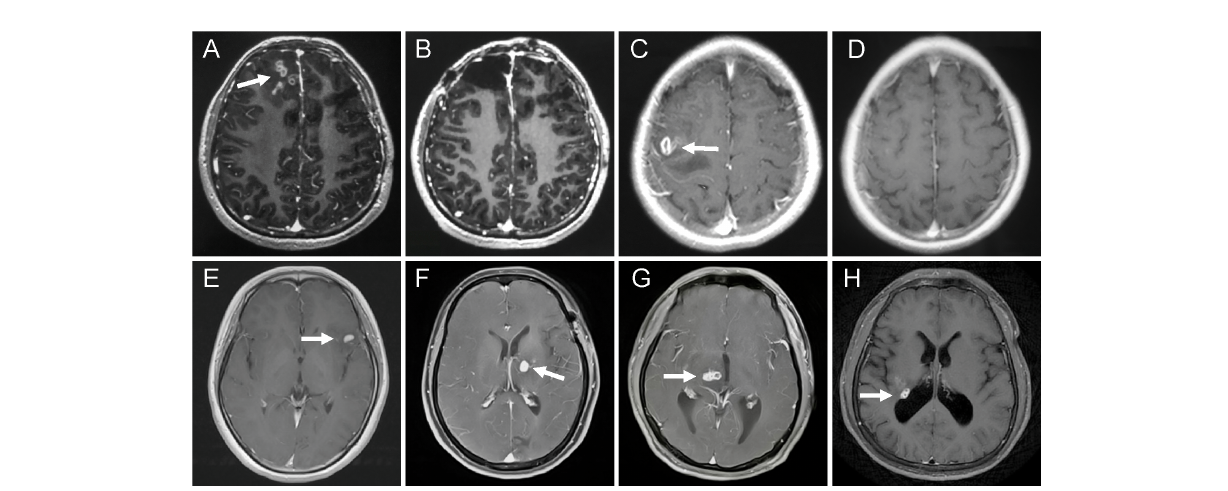
FIGURE 1 MRI changes of the patients with different treatment options and outcomes. (A – D) patients with good outcomes. (A) axial T1-weighted images revealed aggregated bead-shaped enhancement in the subcortical area of the right frontal lobe. (B) the active lesions were removed by surgery. (C) axial enhanced MRI showed nodular enhanced lesions in the left temporal lobe. (D) the enhanced lesions completely disappeared after 12 months with high-dose praziquantel. (E – H) patients with poor outcomes. (E) T1-weighted image demonstrating a crescent-shaped enhanced lesion in the left temporal lobe. (F) a new enhanced lesion reoccurred in the left basal ganglia at six months after surgery. (G) axial T1-weighted image showed a tunnel sign in the right thalamus. (H) T1-weighted image showed a round enhanced lesion in the right lateral posterior ventricle at 12 months after praziquantel